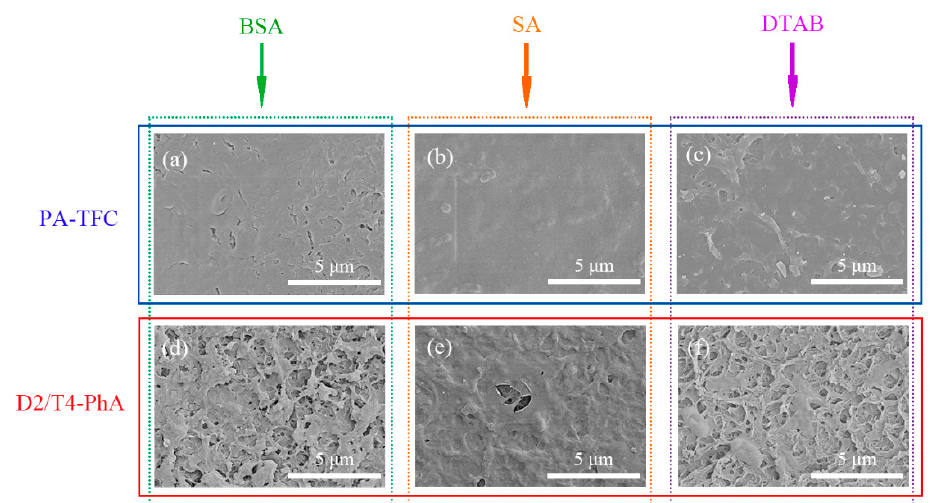
Figure 8. SEM surface images of ( a – c ) PA-TFC and ( d – f ) D2/T4-PhA fouled by ( a , d ) BSA, ( b , e ) SA, or ( c , f ) DTAB, respectively.